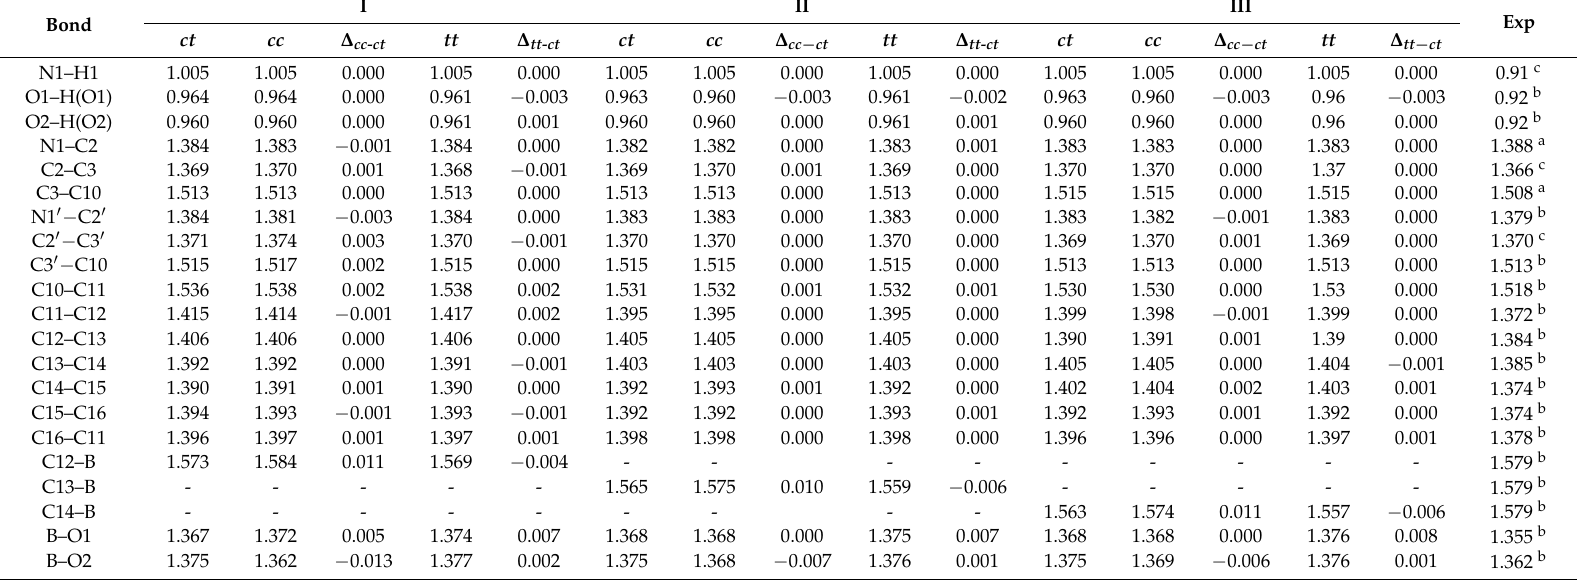
Table 4. Selected theoretical and experimental bond length (Å) of the conformers for I , II and III